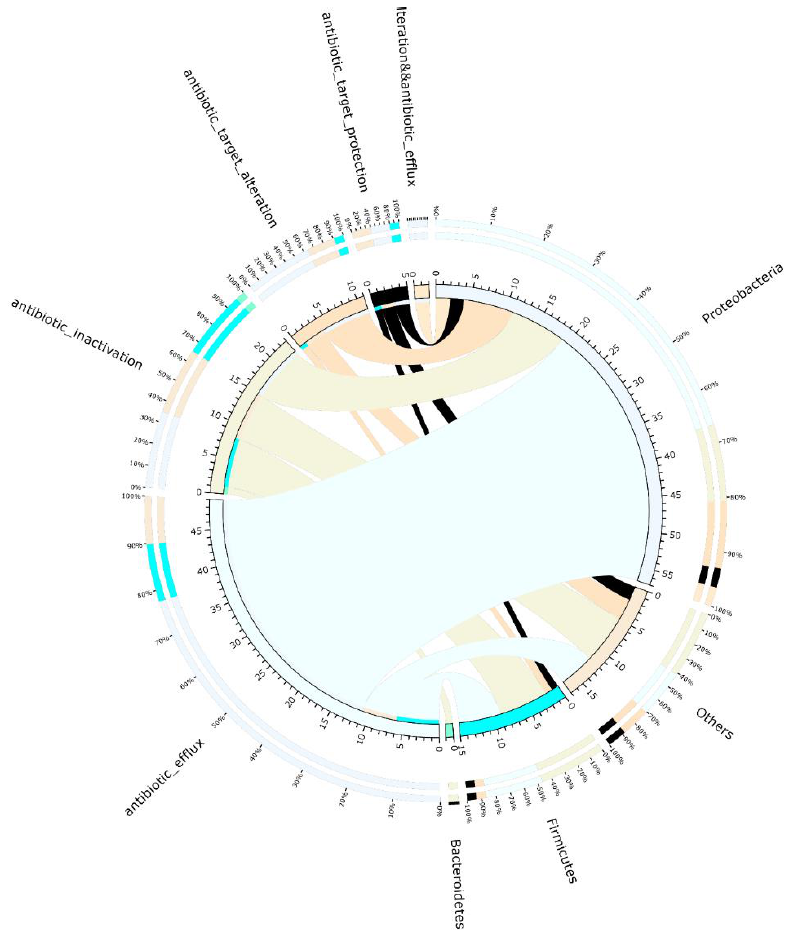
Figure 9. Distributions of ARG types in the microbial phyla. Details are shown in Table